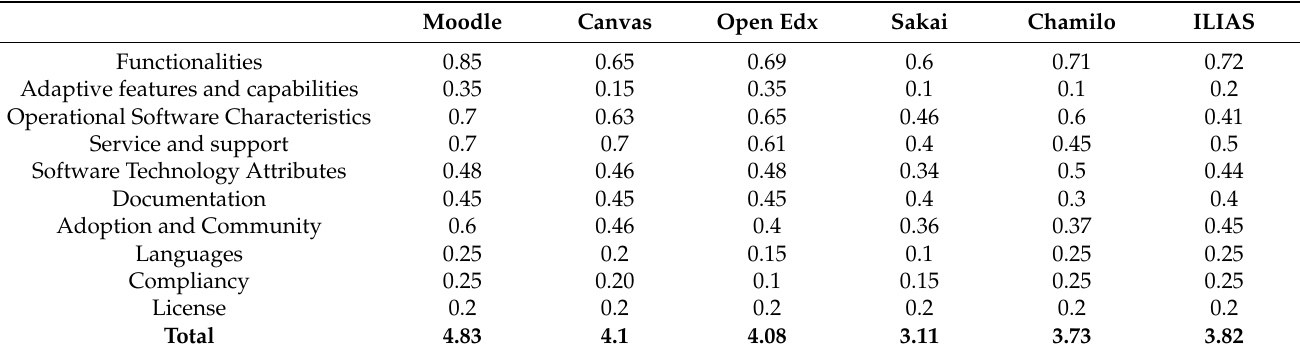
Table 4. Performance of six open source eLearning platforms assessed according to the modified OpenBRR maturity